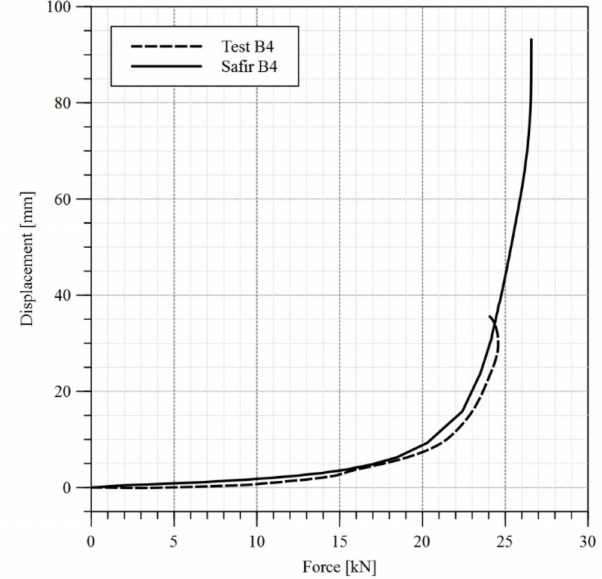
Figure 9. Graph of horizontal displacement measured at the top flange versus force—test